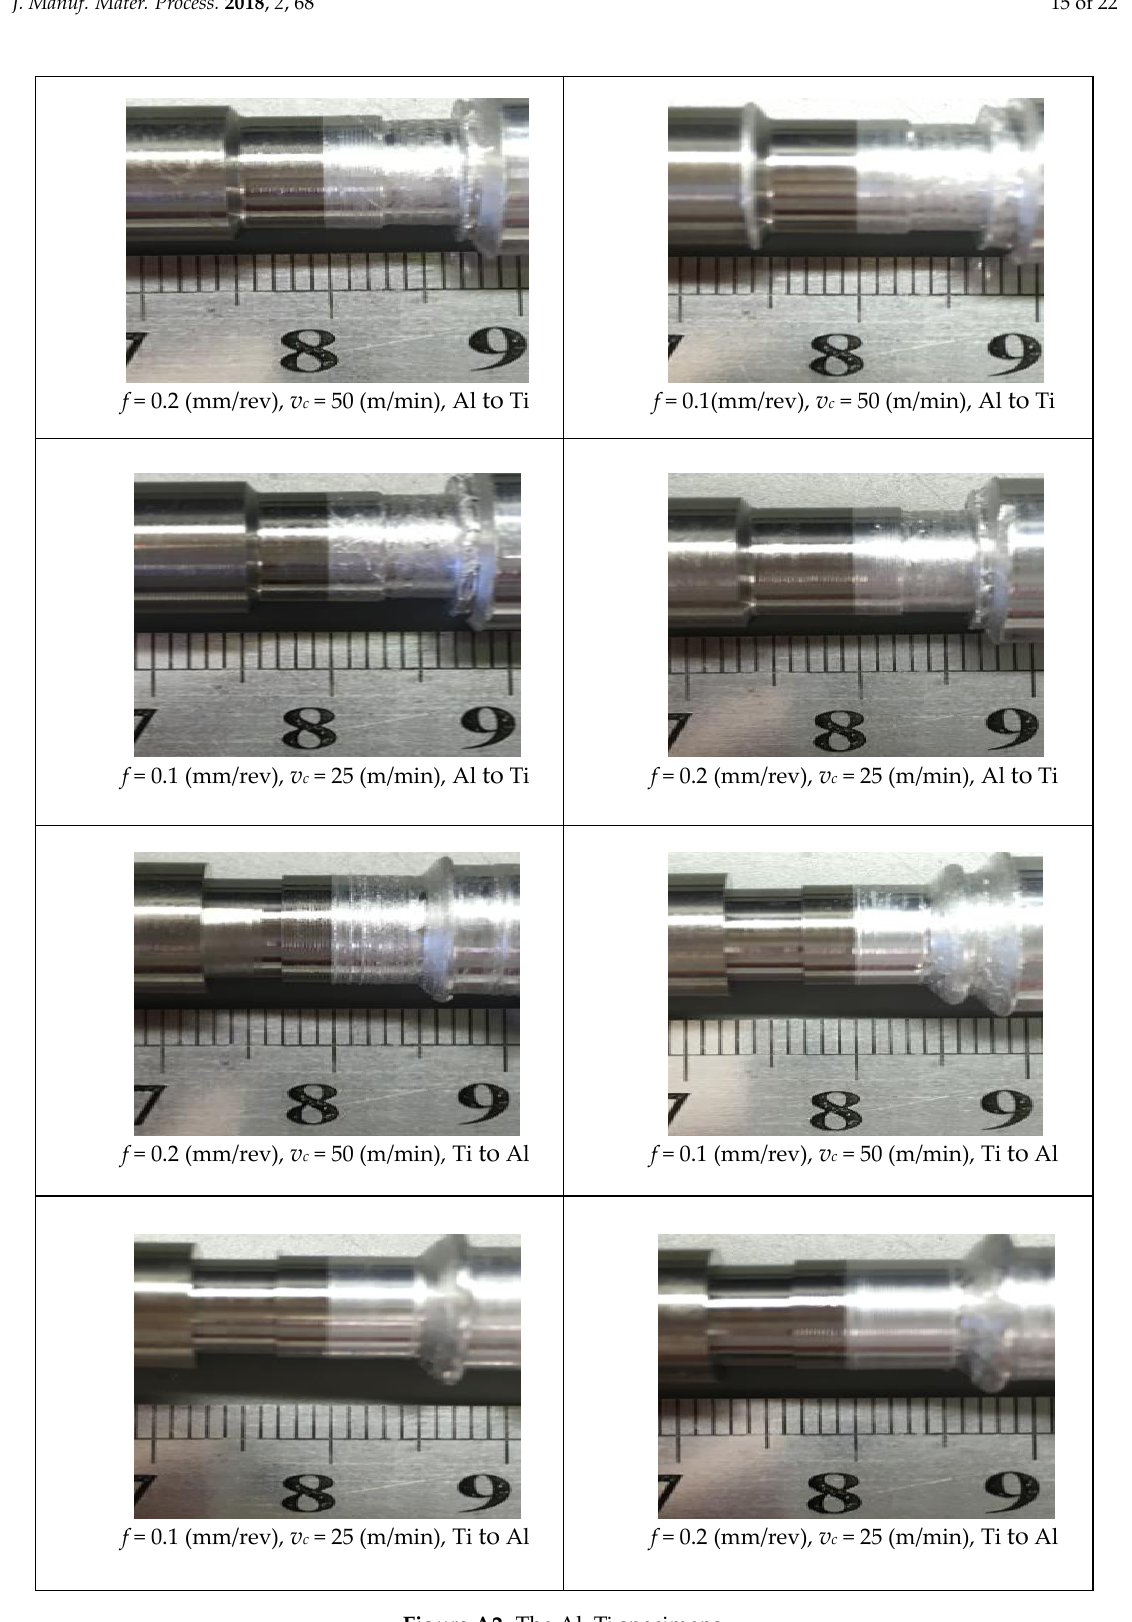
Figure A2. The Al–Ti specimens.